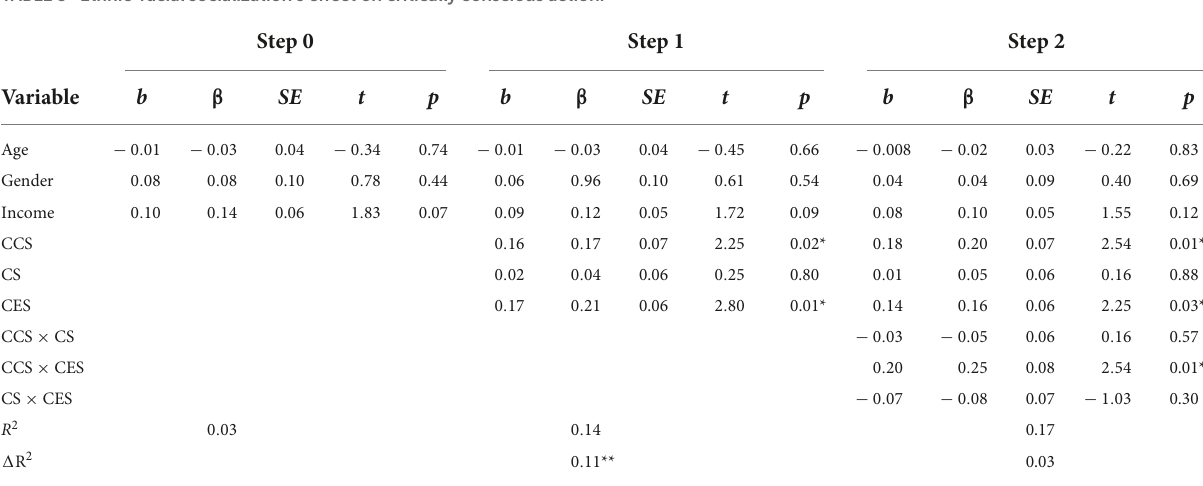
TABLE 3 Ethnic-racial socialization’s effect on critically conscious action.